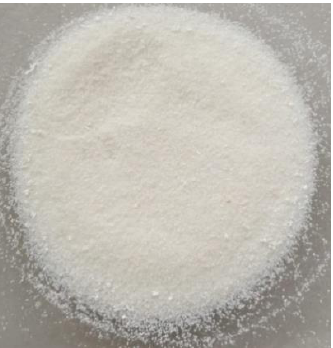
Figure 1. The appearance of the adsorbent material obtained by functionalizing MgSiO 3 using DL-